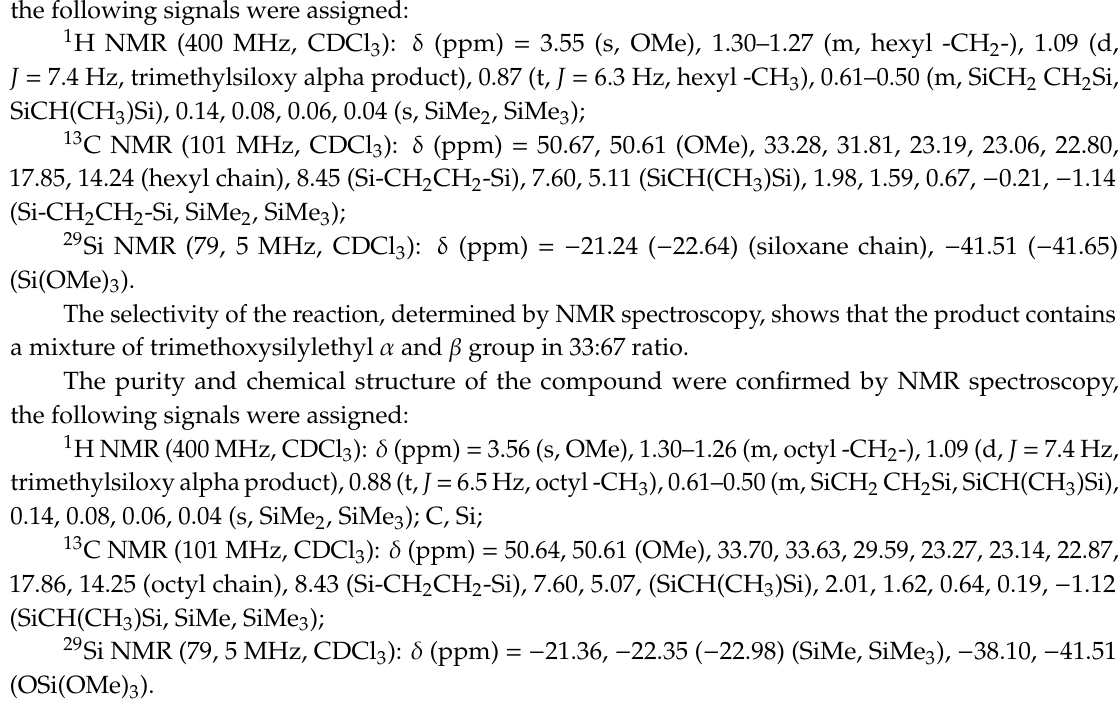
Figure 5. Trimethylsilyl-terminated poly((methyloctylsiloxane)-co-(methyl)((trimethoxysilyl)ethyl)siloxane)) (SILOX3).